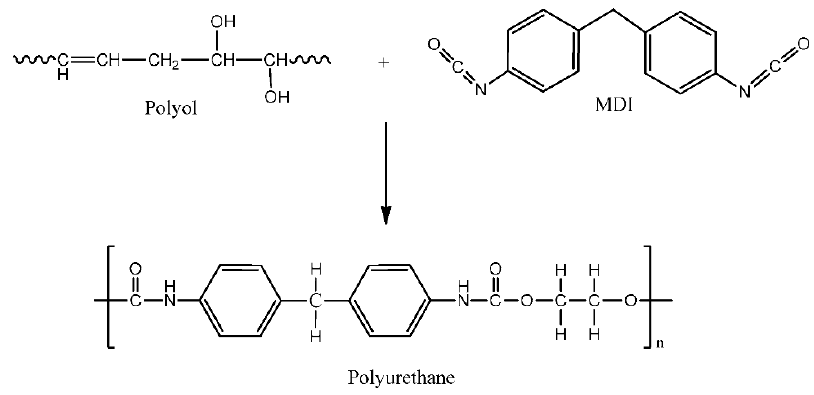
Figure 14. The reaction of polyol and MDI to produce polyurethane.